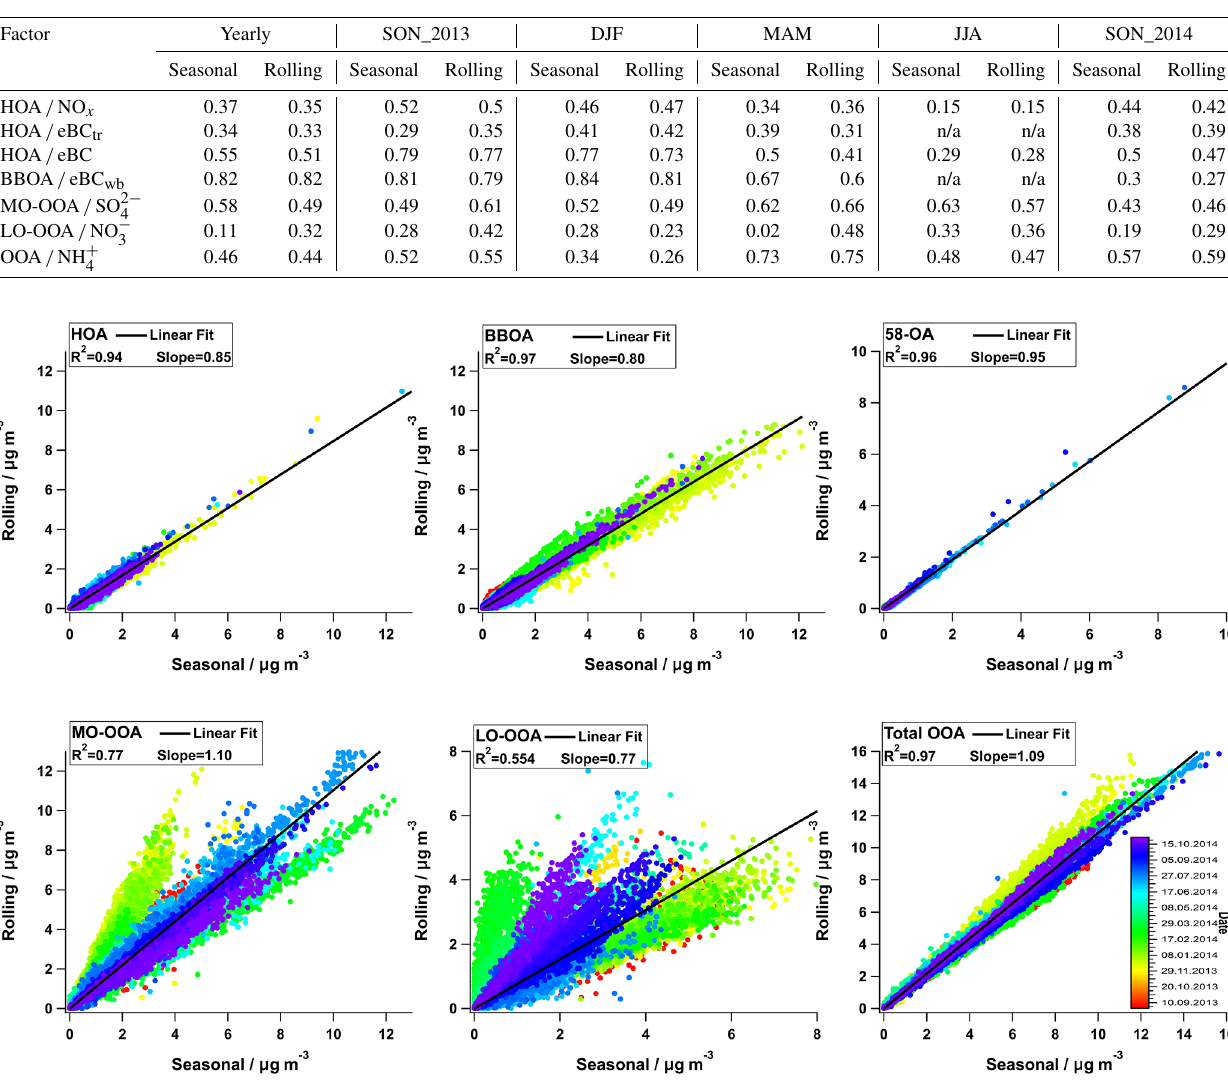
Table A1. Correlation coefficients ( r 2 ) between the factor contributions and expected tracers over the year and for individual meteoro- Pearson logical seasons ( p < 0.05). n/a means not applicable, and the slashes in the first column denote correlations between variables.